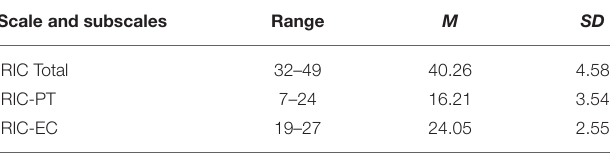
TABLE 1 | Participants’ IRIC total scores and respective subscales scores. Scale and subscales